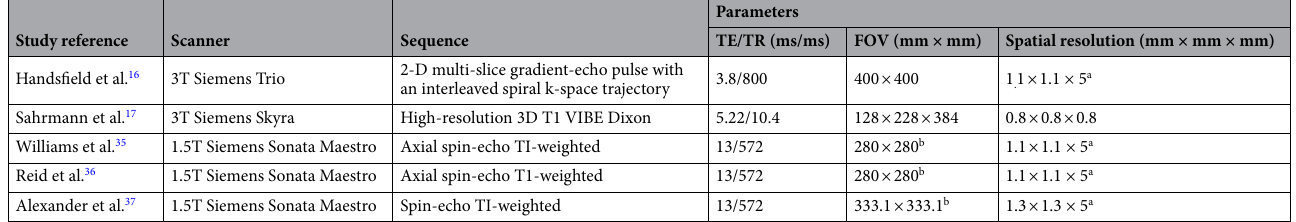
Table 2. Imaging protocols and specifications. a Slice thickness for 2D scanners. b FOV varied by anatomical location. We report here the maximum in each direction and the interpolated spatial